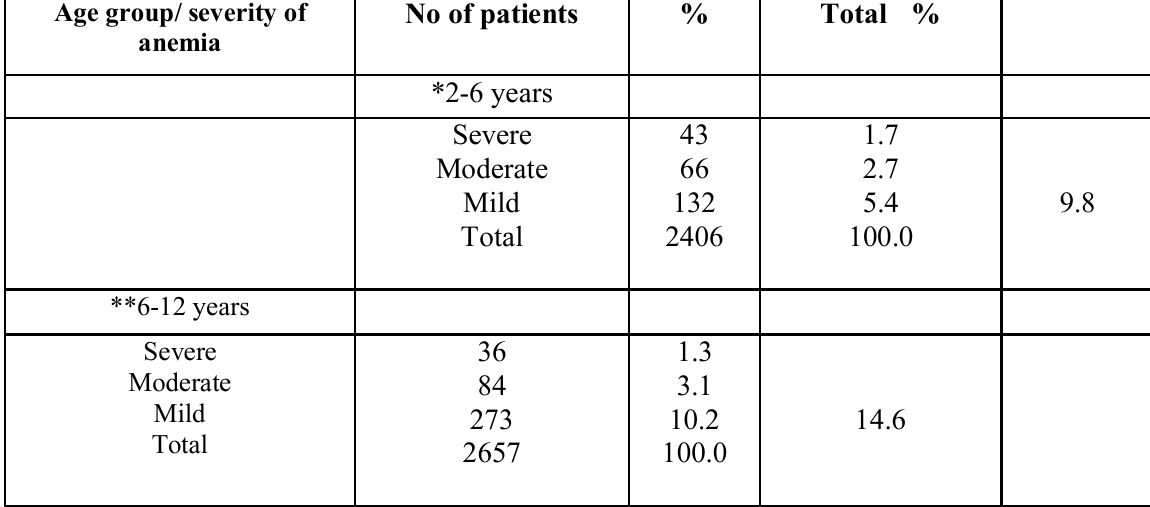
Table 2: Distribution of anaemia based on the Hb levels in children aged 2-6 years and 7-12 years of Nobel Medical College and teaching hospital, Biratnagar, Morang district of Nepal Age group/ severity